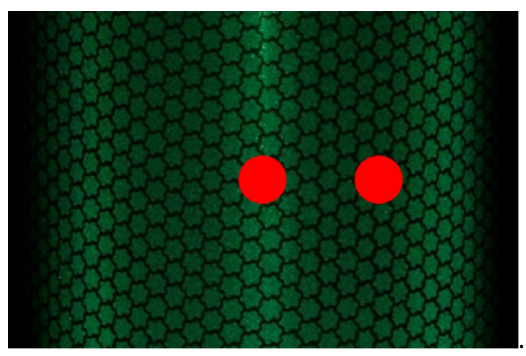
Figure 7. Example of color difference measurement position (red dots). Each projected light on a cylindrical surface was photographed using a digital camera, and the standard deviations of the reflected light and frequency analyses were com-pared. Specifically, we compared and verified the standard deviation of the pixel change in the three horizontal lines within the vertical white line shown in Figure 6, and the results of the frequency analysis of the average of the three lines. As an example, Table 3 shows the standard deviation for the projection of green light on the encapsulated lens type, and Figure 8 shows the frequency analysis for each RGB component. The vertical axis shows the percentage of the normalized cumulative power. Figure 9 also shows the projection results of the proposed method on the capsule cylinder, the projection results when the Lambert reflection was assumed, and the projection results without